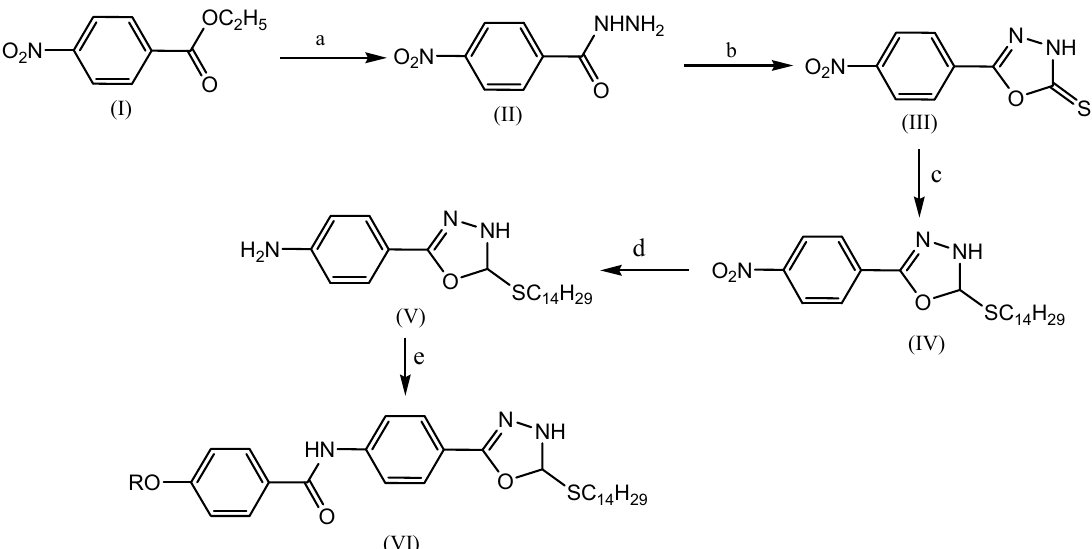
Scheme 13. Synthetic route for series I compounds. Reagents and conditions: ( a ) hydrazine hydrate, ethanol, reflux; ( b ) carbon disulfide, KOH ( c ) 1-bromo tetradecane, triethyl amine; ( d ) stannous chloride; ( e ) substituted alkoxy acid chloride. R = -C n H 2n+1 , where n = 4, 5, 6, 7, 8, 10 ( Ia–f ) and n = chiral alkoxyacid chloride ( Ig , h ).